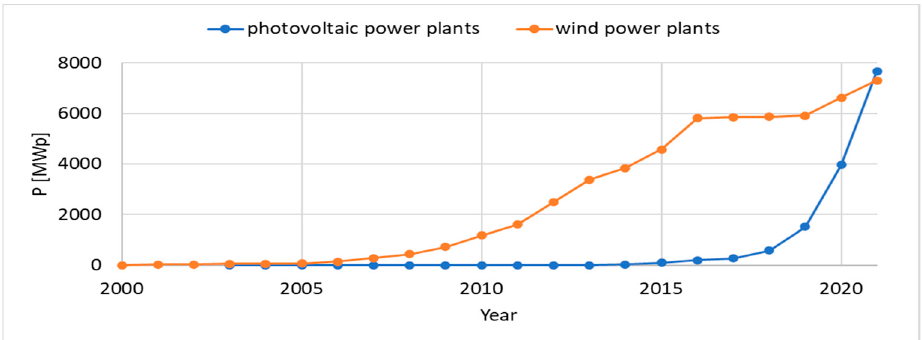
Figure 2. Installed power in photovoltaic and wind power plants in Poland (own elaboration based on IEO and GUS data).